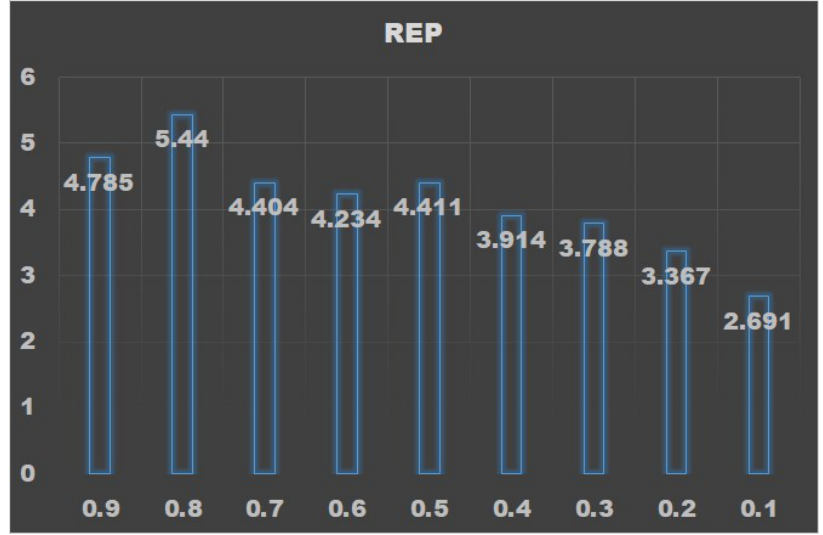
Figure 3. REP trend with respect to p value.